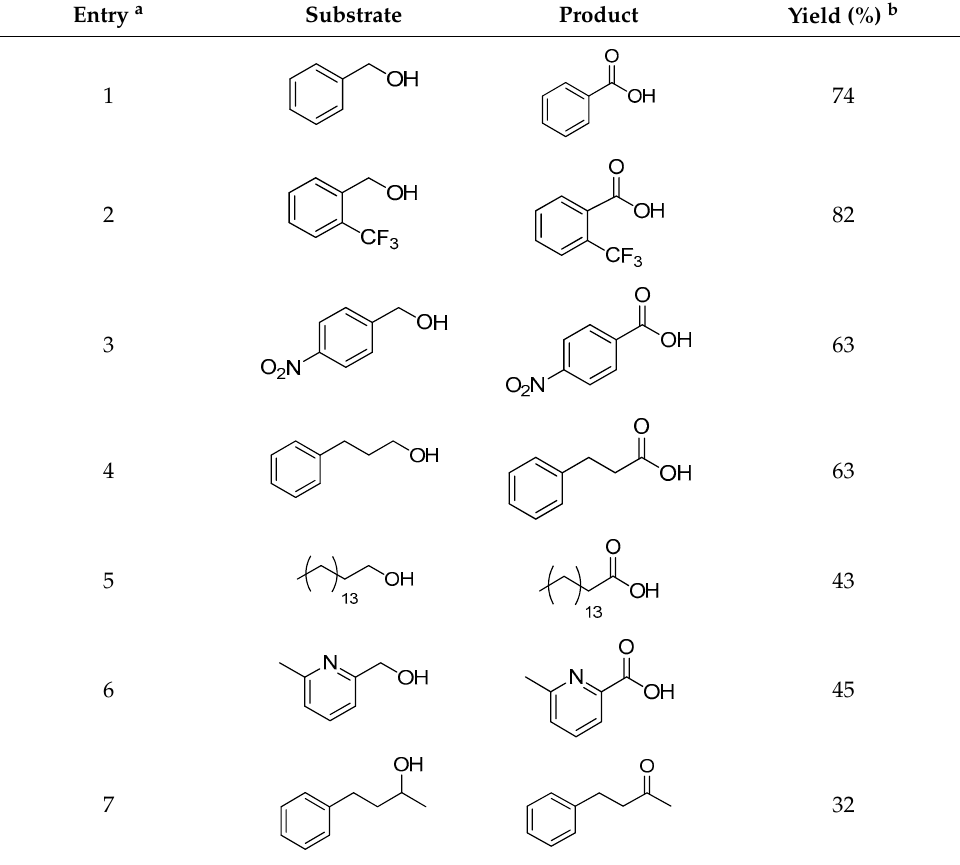
Table 3. Scope of oxidation with ( 1) , (P 6,6,6,14 ) 4 [W 10 O 32 ], as catalyst and H 2 O 2 as co oxidant.